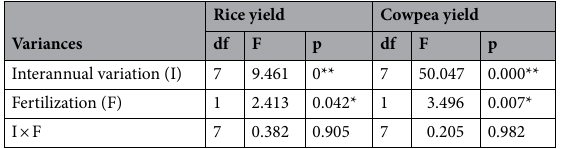
Table 5. ANOVA for rice and cowpea yield under different fertilization treatments 2014–2021. Stars indicated the level of signifcance (*p < 0.05,**p < 0.01).